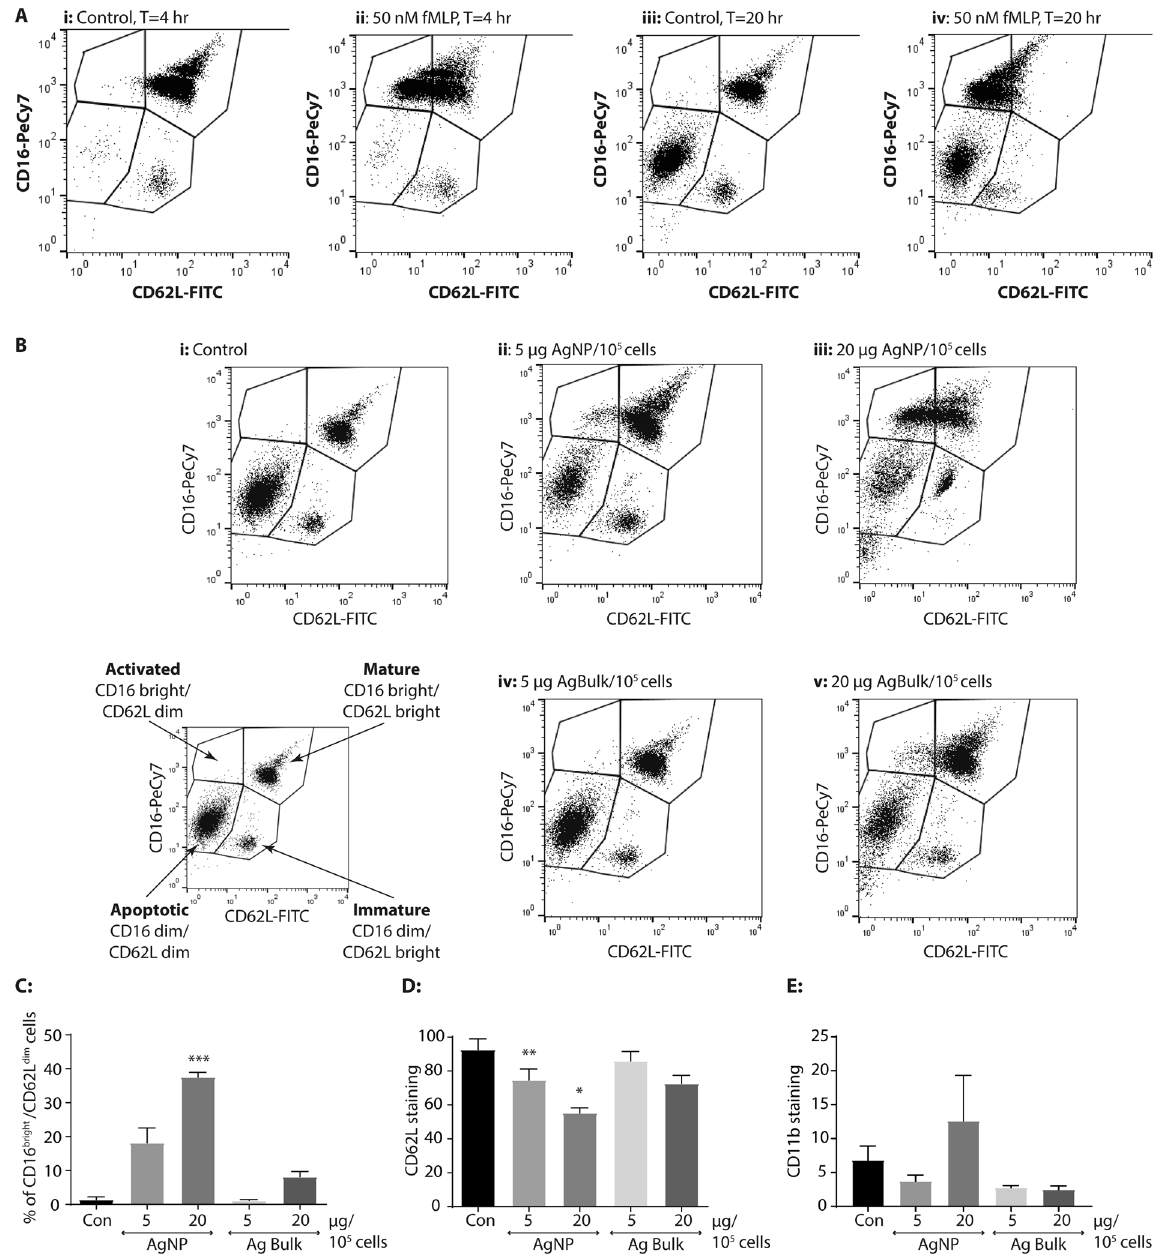
Figure 3. Exposure to silver nanoparticles triggers neutrophil activation. ( A ) Representative profiles obtained from a typical flow cytometry analysis of CD16-PeCy7 and CD62L-FITC stained control (i and iii) or 50 nM fMLP (ii and iv; n = 2) treated human neutrophils, after 4 hr (panel i and ii) or 20 hr (panel iii and iv) in vitro . ( B ) Representative profiles obtained from a typical flow cytometry analysis of human neutrophils 20 hr after treatment with silver nanoparticles, staining with CD16-PeCy7 and CD62L-FITC. Panel i: control, ii and iii: 5 or 20 µ g AgNP; iv and v: 5 or 20 µ g Ag Bulk particles per 10 5 cells; ( B ) Inset panel: division of neutrophil populations based on CD62L-FITC and CD16-PeCy7 staining profile. Sub-populations were identified by further gating on their CD16 status and the percentage of CD16 bright /CD62L dim cells ( C ), geometric mean of CD62L staining of CD16 bright cells ( D ) and geometric mean of CD11b staining of CD62 bright /CD16 dim cells ( E ) was analysed. Data is expressed as the mean ± SEM where n = 4. * p < 0.05 ** p < 0.01 *** p <